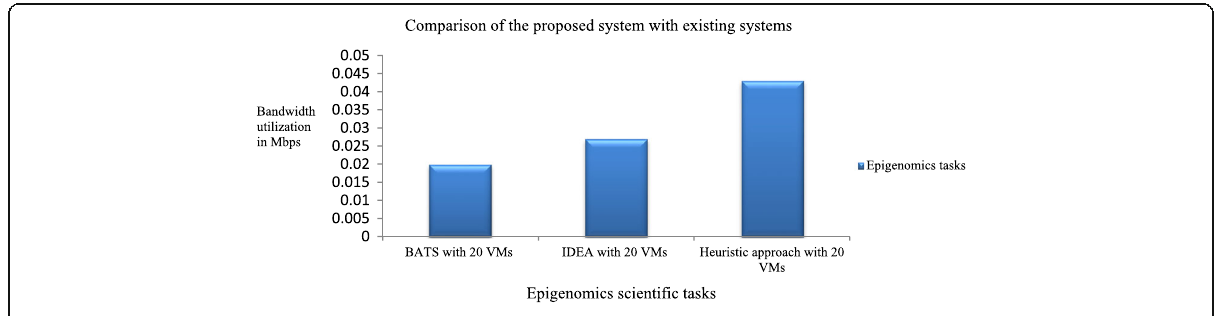
Fig. 15 Bandwidth comparisons for Epigenomics